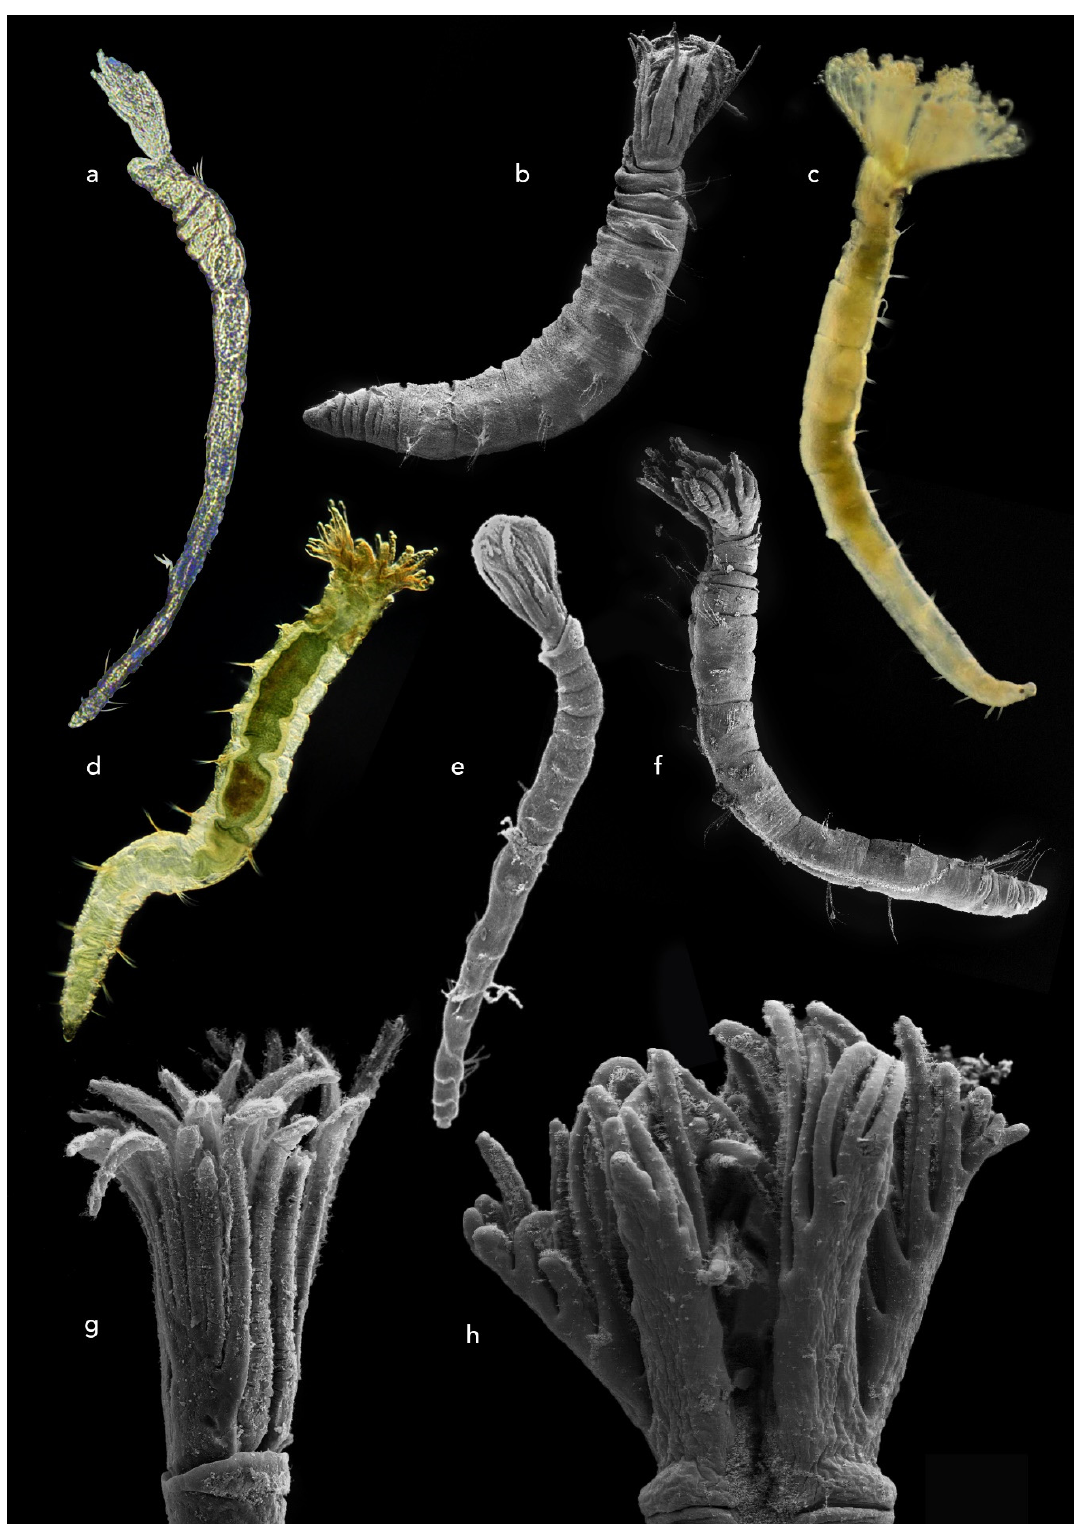
Figure 3. Some fabriciid representatives showing a range of the diversity of forms found in the group. ( a ) cf. Fabriciola sp., deep-sea basin of the southwest Atlantic; ( b,c,h ) Fabricia stellaris , Baltic Sea; ( d,f ) Manayunkia athalassia, South Australia; ( e ) Fabriciola sp., Brazil ( g ) Monroika sp., Argentina (c by A. Dietrich, d by G. Rouse, g by L. Armendariz).